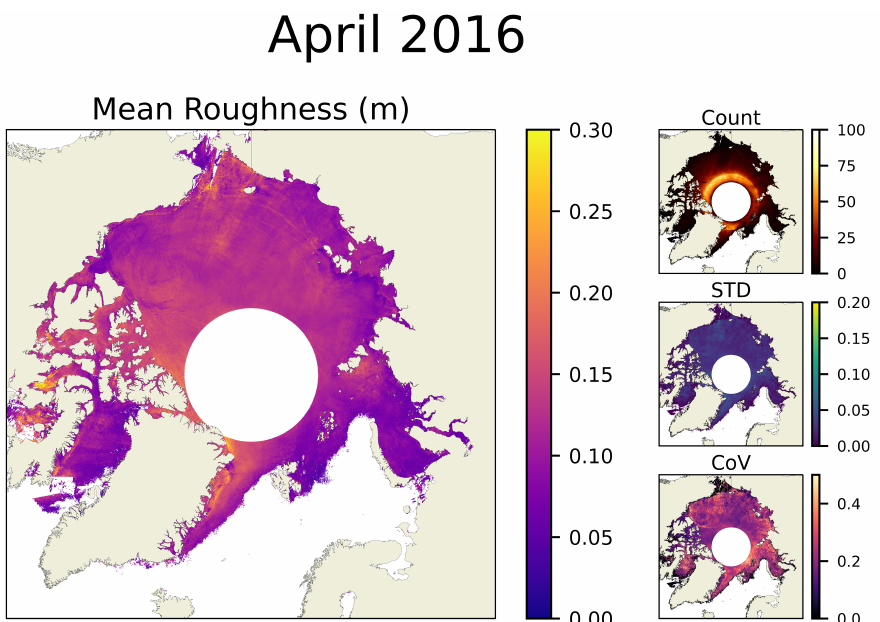
Figure 10. A sample monthly aggregated roughness product for April 2016; mean roughness ( left ); number of observations ( top right ); standard deviation of samples ( middle right ); coefficient of variation ( bottom right ), where CoV = standard deviation of roughness/mean roughness. WGS 84/NSIDC EASE-Grid 2.0 North. Generated using Cartopy and